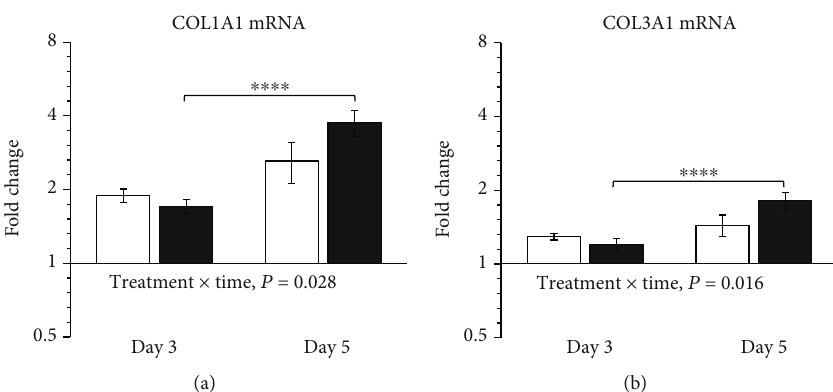
Figure 4: COL1A1 (a) and COL3A1 (b) mRNA levels in anastomotic wounds on days 3 and 5 were normalized to RPLP0 and shown as fold changes relative to the resected noninjured colon of vehicle-treated rats on day 0. Open bars: vehicle; fi lled bars: ZP1849. ∗∗∗∗ P < 0 : 0001 . Geometric mean ± back ‐ transformed SEM.